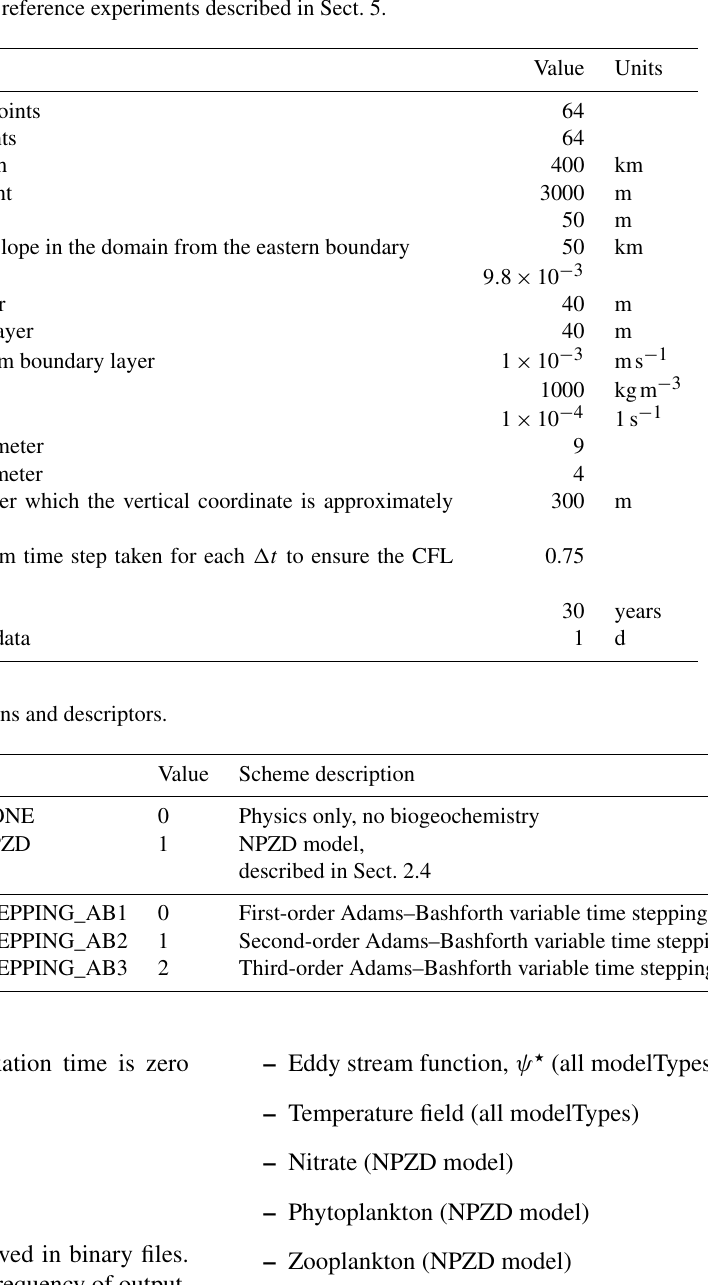
Table 3. Input parameters expected by the MAMEBUS model code. All parameters listed in this table are chosen by the user. The sample values listed in this table are those used in the reference experiments described in Sect. 5.